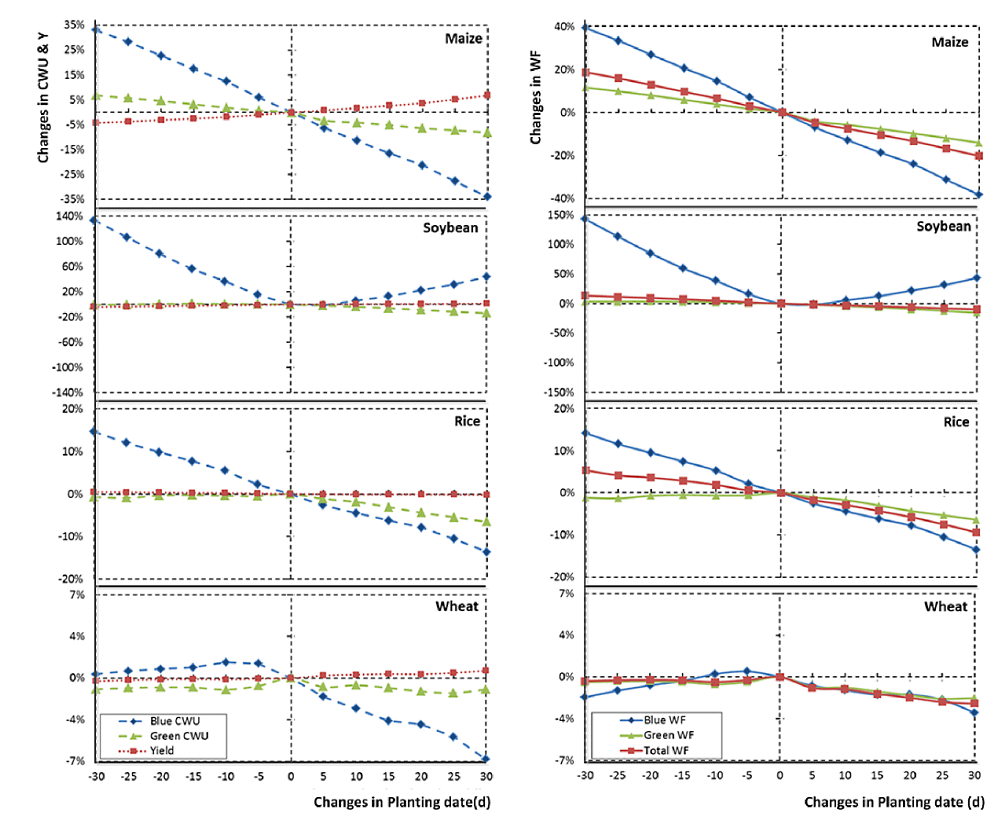
Figure 5. Sensitivity of CWU, Y and WF to changes in crop planting date ( D ),